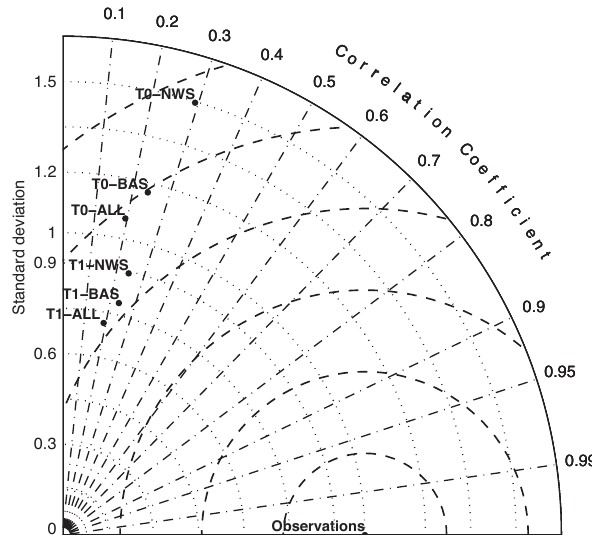
Figure 7. Taylor diagram for comparison with in situ chlorophyll for the entire area (ALL), the Barents Sea (BAS) and the Norwegian Sea including station M (NWS). The curved dotted lines show the standard deviation relative to the